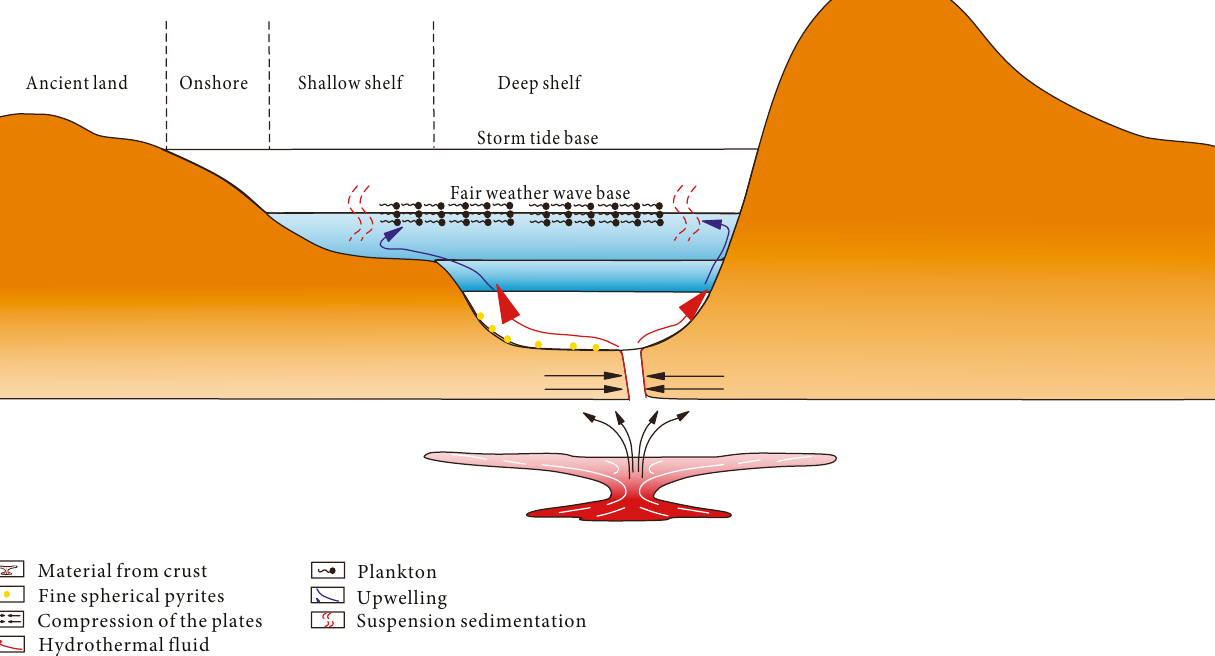
Figure 9: The mechanism underlying sedimentary organic matter enrichment in the upper Ordovician-lower Silurian shale from the lower Yangtze region. The active hydrothermal activity near the junction of the two plates (Yangtze Plate and Cathaysian Plate) led to high paleoproductivity and an oxygen-de fi cient environment [31,